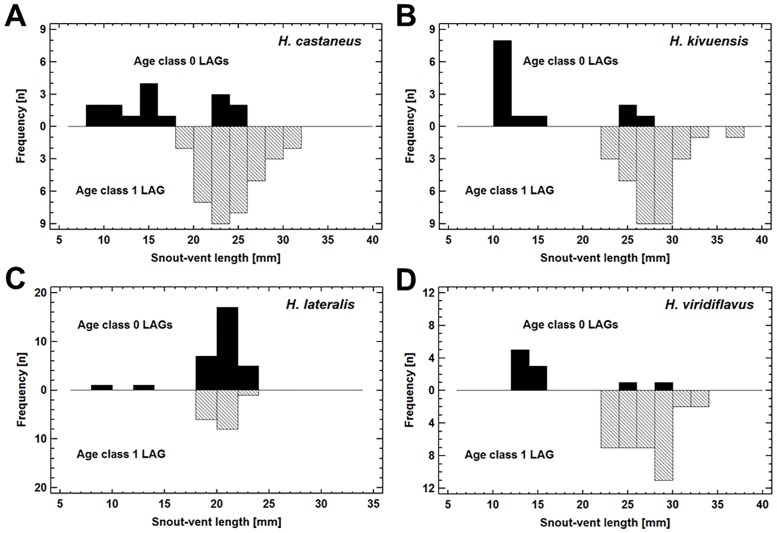
Size distribution of all 0 LAG and 1 LAG individuals of H. castaneus (A), H. kivuensis (B), H. lateralis (C) and H. viridiflavus (D).All 1 LAG and few 0 LAG individuals were sexually mature (usually males, see Table 1). The bars represent 2mm size classes of the individuals.